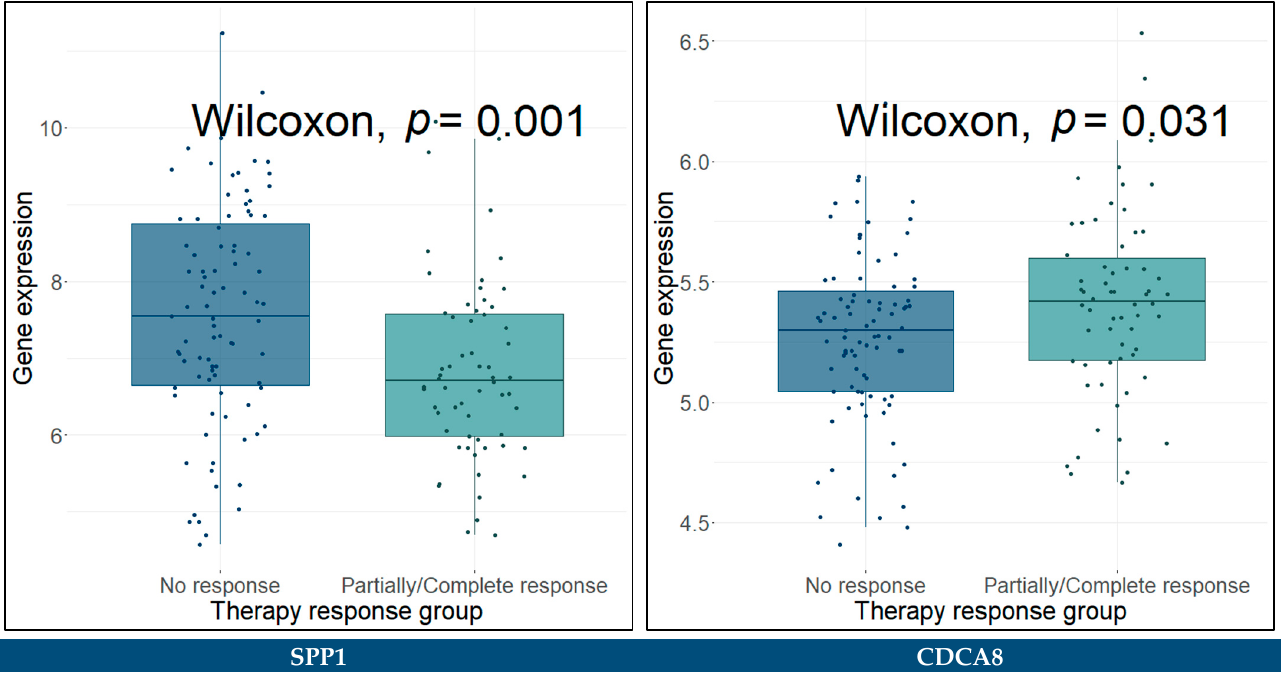
Figure 20. Significantly differentially expressed key hub genes between “No response” and “Par- tially/Complete response” for preoperative cisplatin-based chemotherapy groups of MIBC patients.